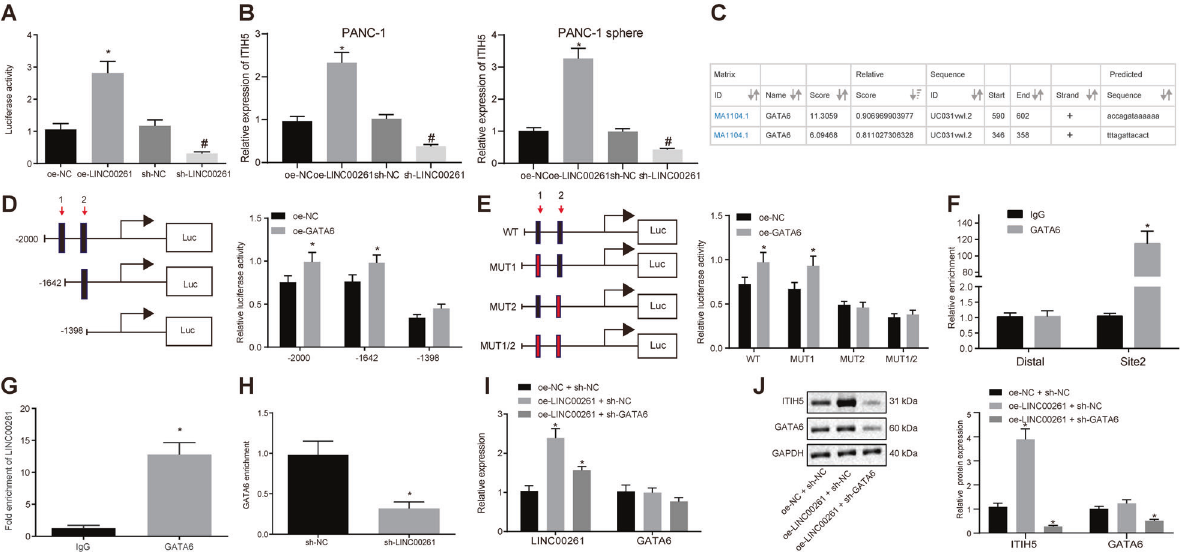
Fig. 4 LINC00261 upregulates ITIH5 expression by recruiting GATA6. A The effect of LINC00261 on the activity of ITIH5 promoter in the PANC-1 spheres, examined by dual-luciferase reporter gene assay; * p < 0.05 vs. the oe-NC group; # p < 0.05 vs. the sh-NC group. B Expression of ITIH5 in PANC-1 cells and spheres examined by RT-qPCR, * p < 0.05 vs. the oe-NC group; # p < 0.05 vs. the sh-NC group. C Two potential binding sites of GATA6 and ITIH5 DNA predicted by UCSC and JASPAR. D Cotransfection of truncated ITIH5 recombinant luciferase reporter gene vector and GATA6 overexpression vector into PANC-1 stem cells; * p < 0.05 vs. the oe-NC group. E Cotransfection of mutant ITIH5 recombinant luciferase reporter gene vector and GATA6 expression vector into PANC-1 stem cells; * p < 0.05 vs. the oe-NC group. F Binding of GATA6 in site